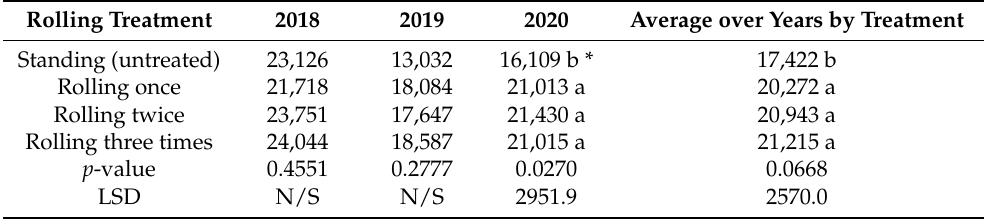
Table 11. Bush beans yield (kg ha − 1 ) in each growing season and average yield over all growing seasons with respect to rolling